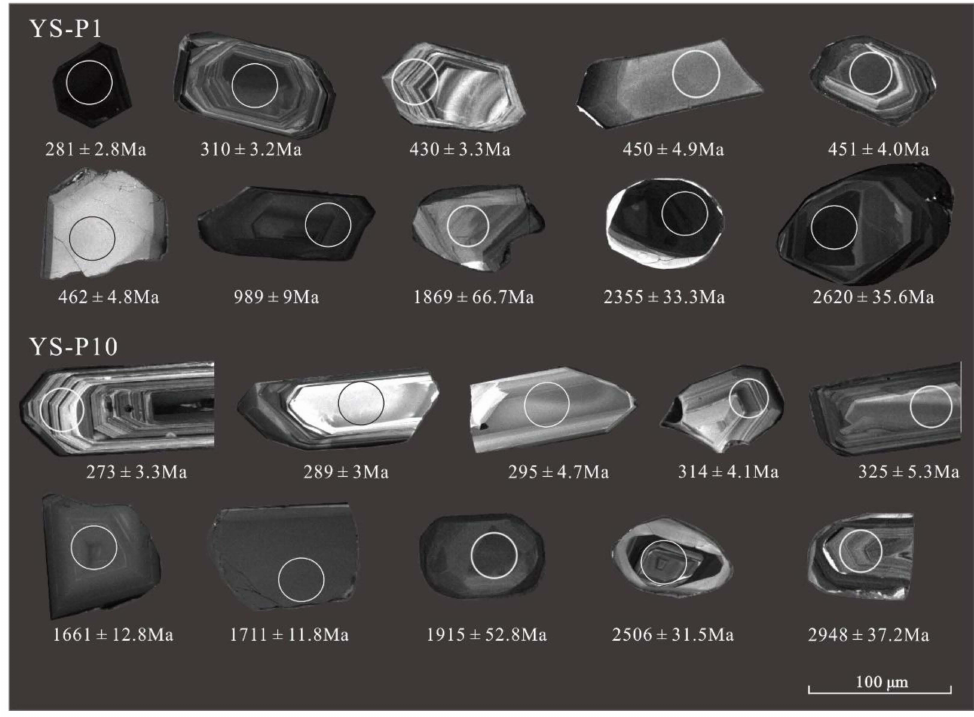
Figure 3. Representative CL images and U-Pb ages of detrital zircons from the two samples showing variations in size and morphology. The circles are analytical